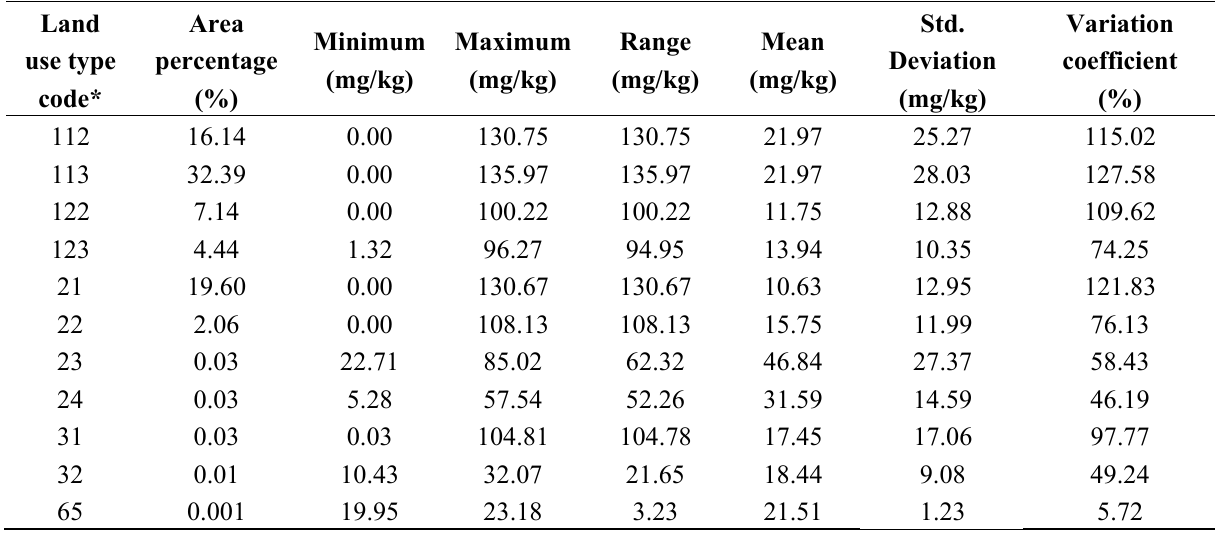
Table 8. Summary statistics of soil available phosphorus of different land use